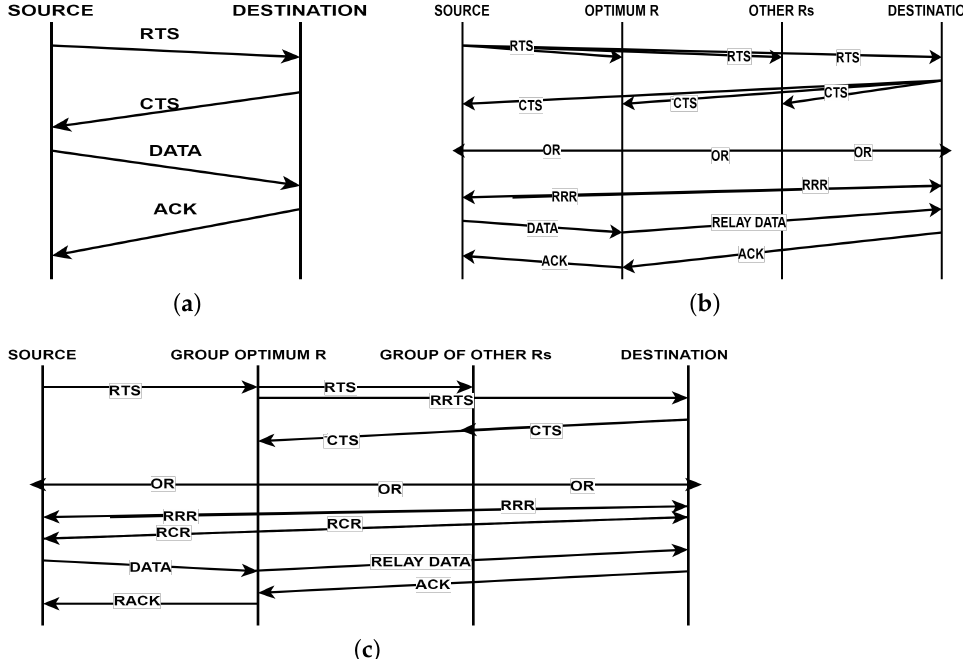
Figure 13. Mechanism of packet exchange: ( a ) DT mode, ( b ) CR mode, and ( c ) MHR mode